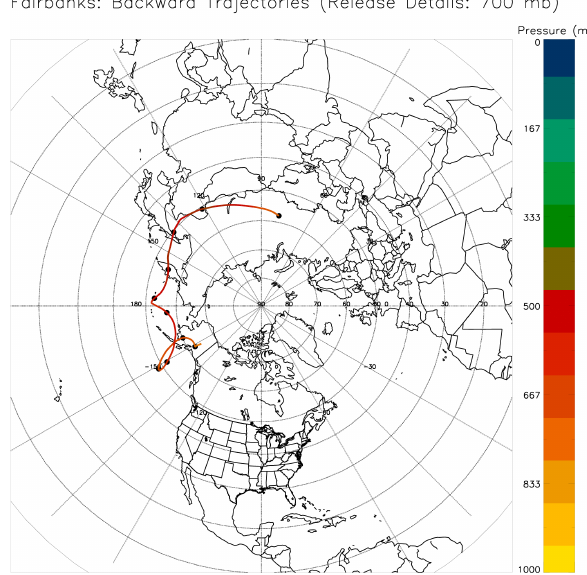
Fig. 20. FLEXPART back trajectory ending 21 April 2008 at 700hPa over Fairbanks, Alaska. Each black dot represents one